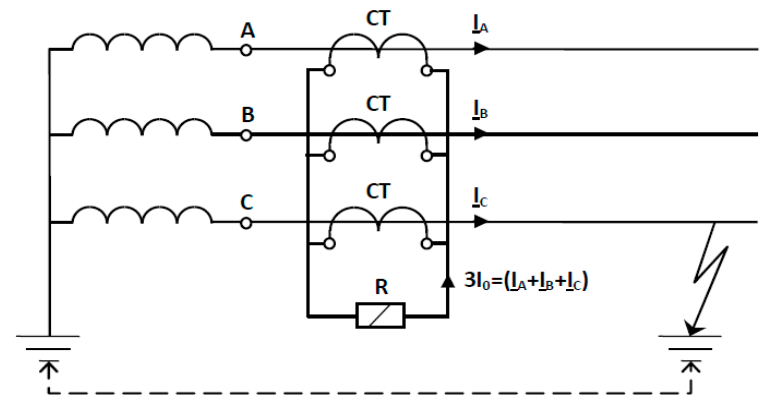
Figure 4. The principle of residual (Holmgreen) CT connection (CTs—line current transformers) [28].